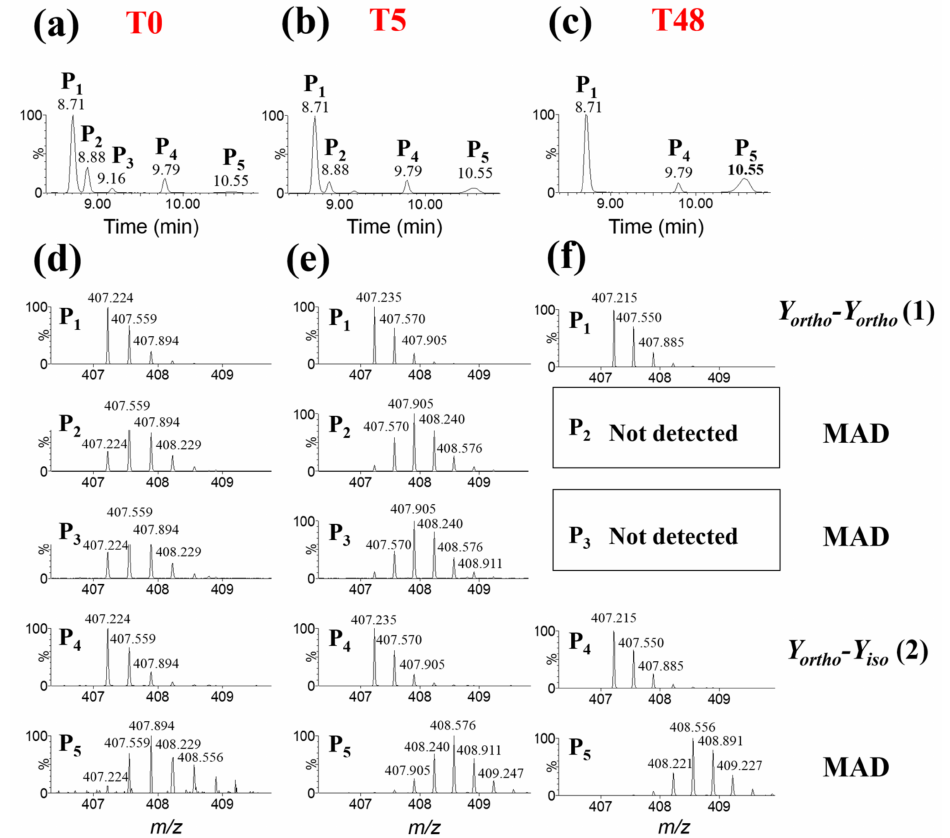
Figure 2. Oxidation of peptide KTSLY at 40 Gy in N 3 • production conditions. Extracted ion chro- matograms at m / z 407.22 ± 0.05 for [M + 3H] 3+ after oxidation in H 2 O at ( a ) T0 (0 h), ( b ) T5 (5 h) and ( c ) T48 (48 h). Full scan MS spectra for [M + 3H] 3+ extracted at RT of dimers after oxidation in D 2 O at ( d ) T0 (0 h), ( e ) T5 (5 h) and ( f ) T48 (48 h). Minor peaks in mass spectra arise from isotopic